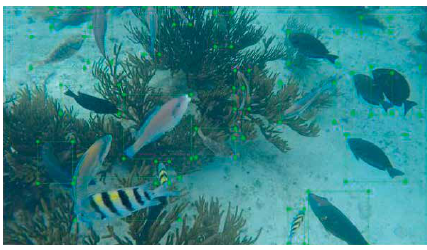
Figure 11: Labelled ground